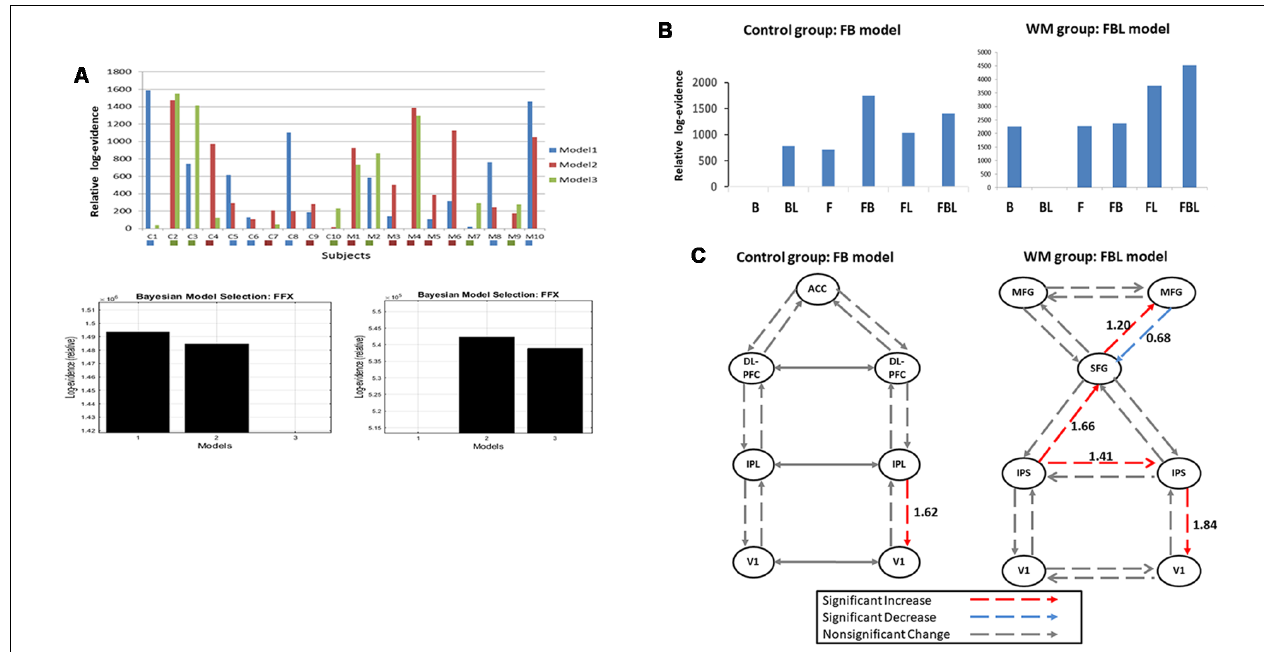
FIGURE 4 | (A) Model selection results at the individual level (upper panel) and the group level for the control (left, lower panel) and the working memory (WM) training (right, lower panel) groups. C1–10: the control group; M1–10: the WM group. The colored box under each subject indicates the subject-specific winning model. (B) Model selection results of the modulatory effects for the control (left) and the WM training groups (right). B, backward; F, forward; L, lateral. (C) Group-specific modulations at W3. Left, the control group; Right, the WM group.